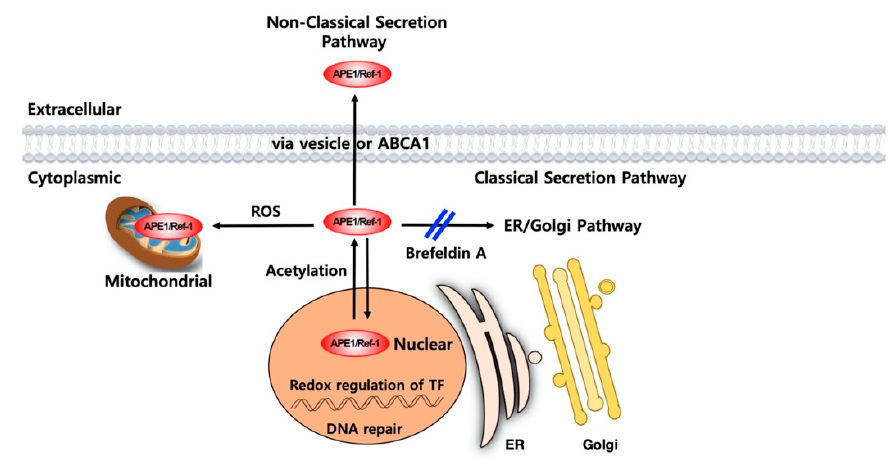
Figure 3. Proposed secretion mechanism of APE1 / Ref-1. APE1 / Ref-1 is mainly localized in the nucleus, which is dynamically regulated between the cytoplasm or mitochondria. Also, APE1 / Ref-1 may be secreted in response to acetylation. Its secretion is not inhibited by brefeldin A, an inhibitor of the ER / Golgi pathway (‘double slash’ in blue), suggesting a nonclassical secretion pathway. Active secretion of APE1 / Ref-1 may be mediated by the ABCA1 transporter or vesicle formation [54,57] .